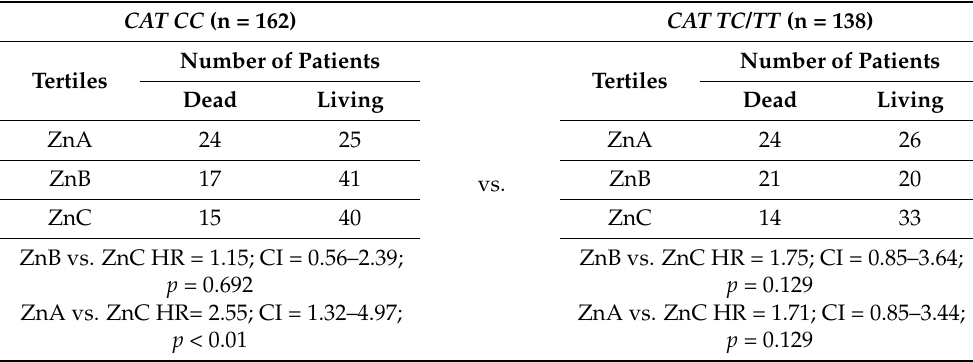
Table 6. Impact on survival of zinc serum level depending on CAT polymorphism (multivariable Cox regression).